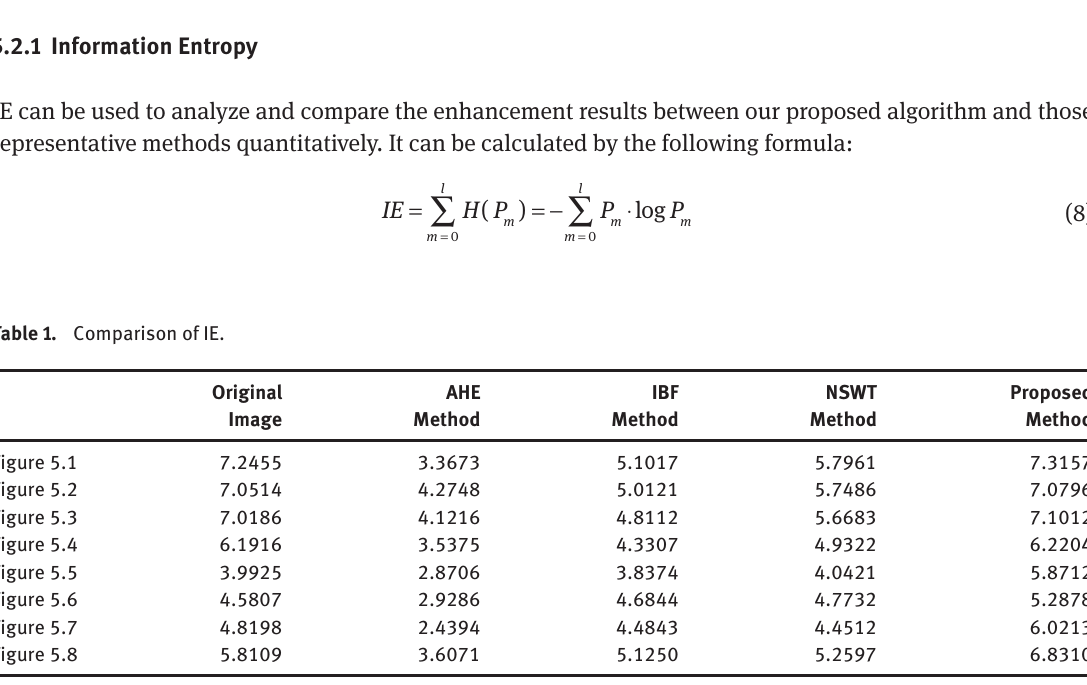
Table 2. Comparison of SF.